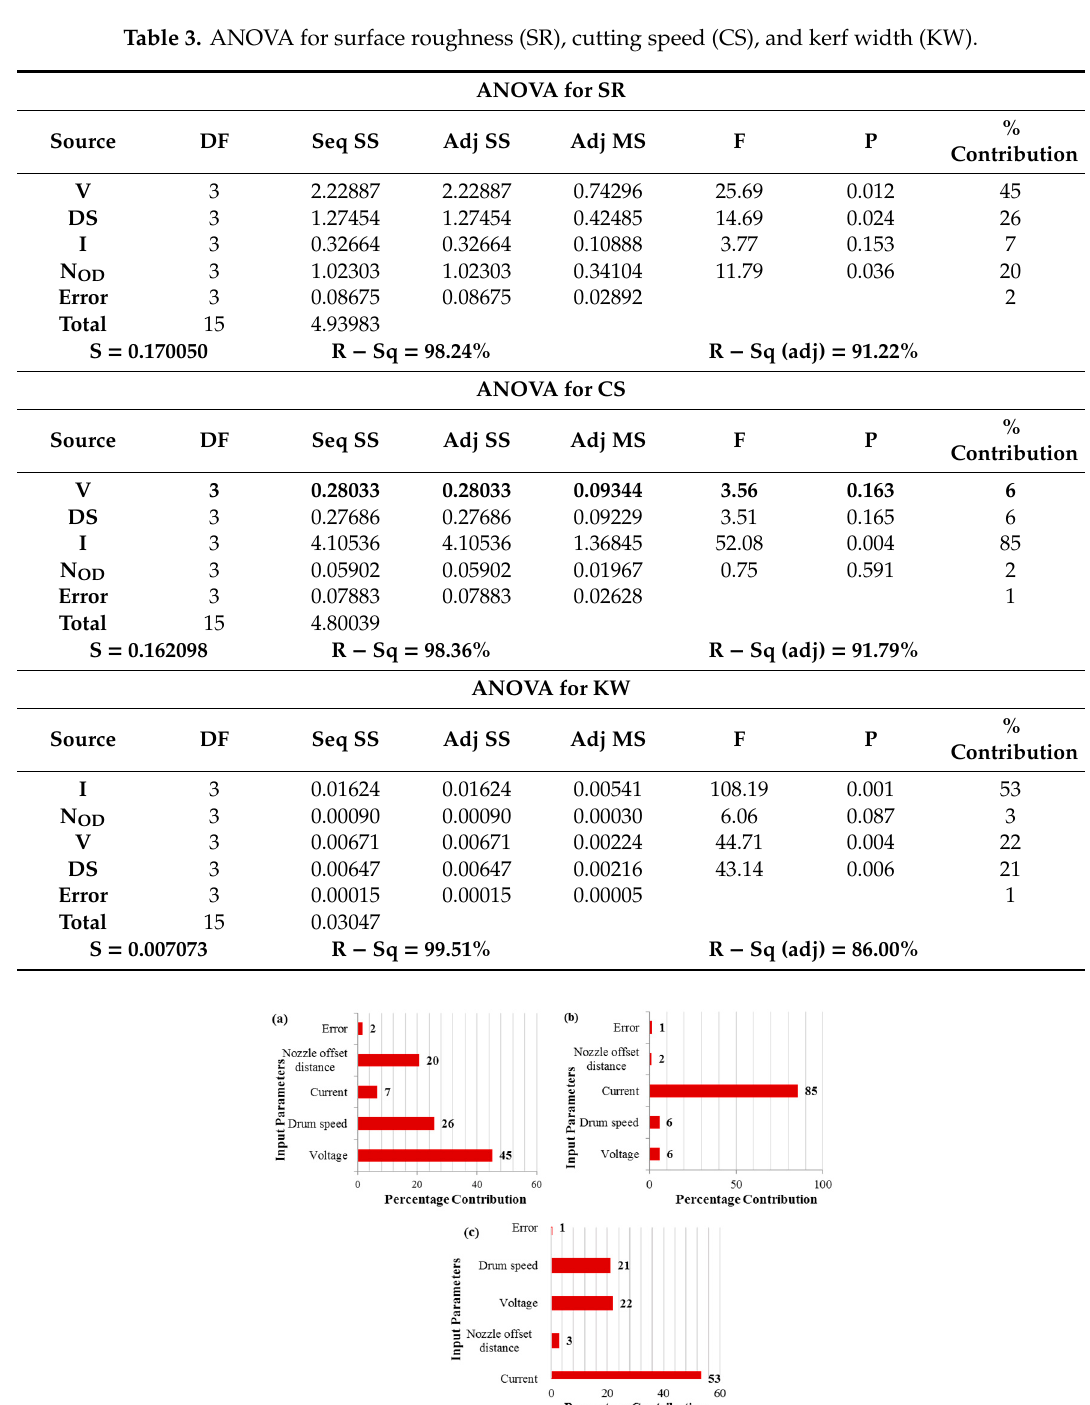
Figure 2. Percentage contribution of factors for ( a ) SR, ( b ) CS, and ( c )